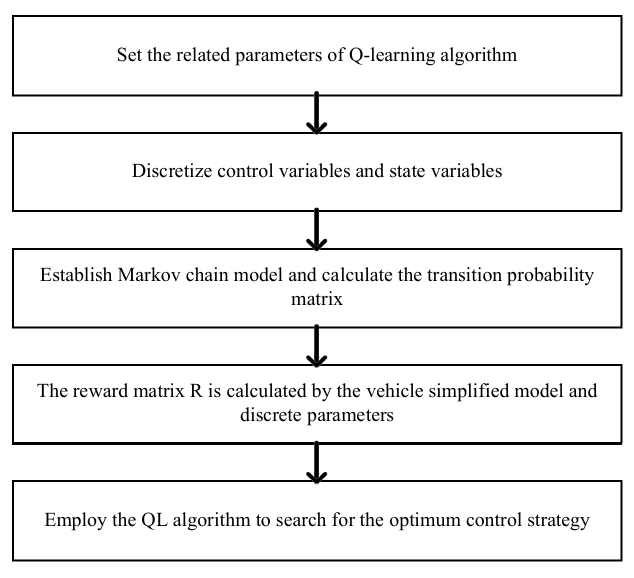
Figure 6. Procedures of the QL calculation.